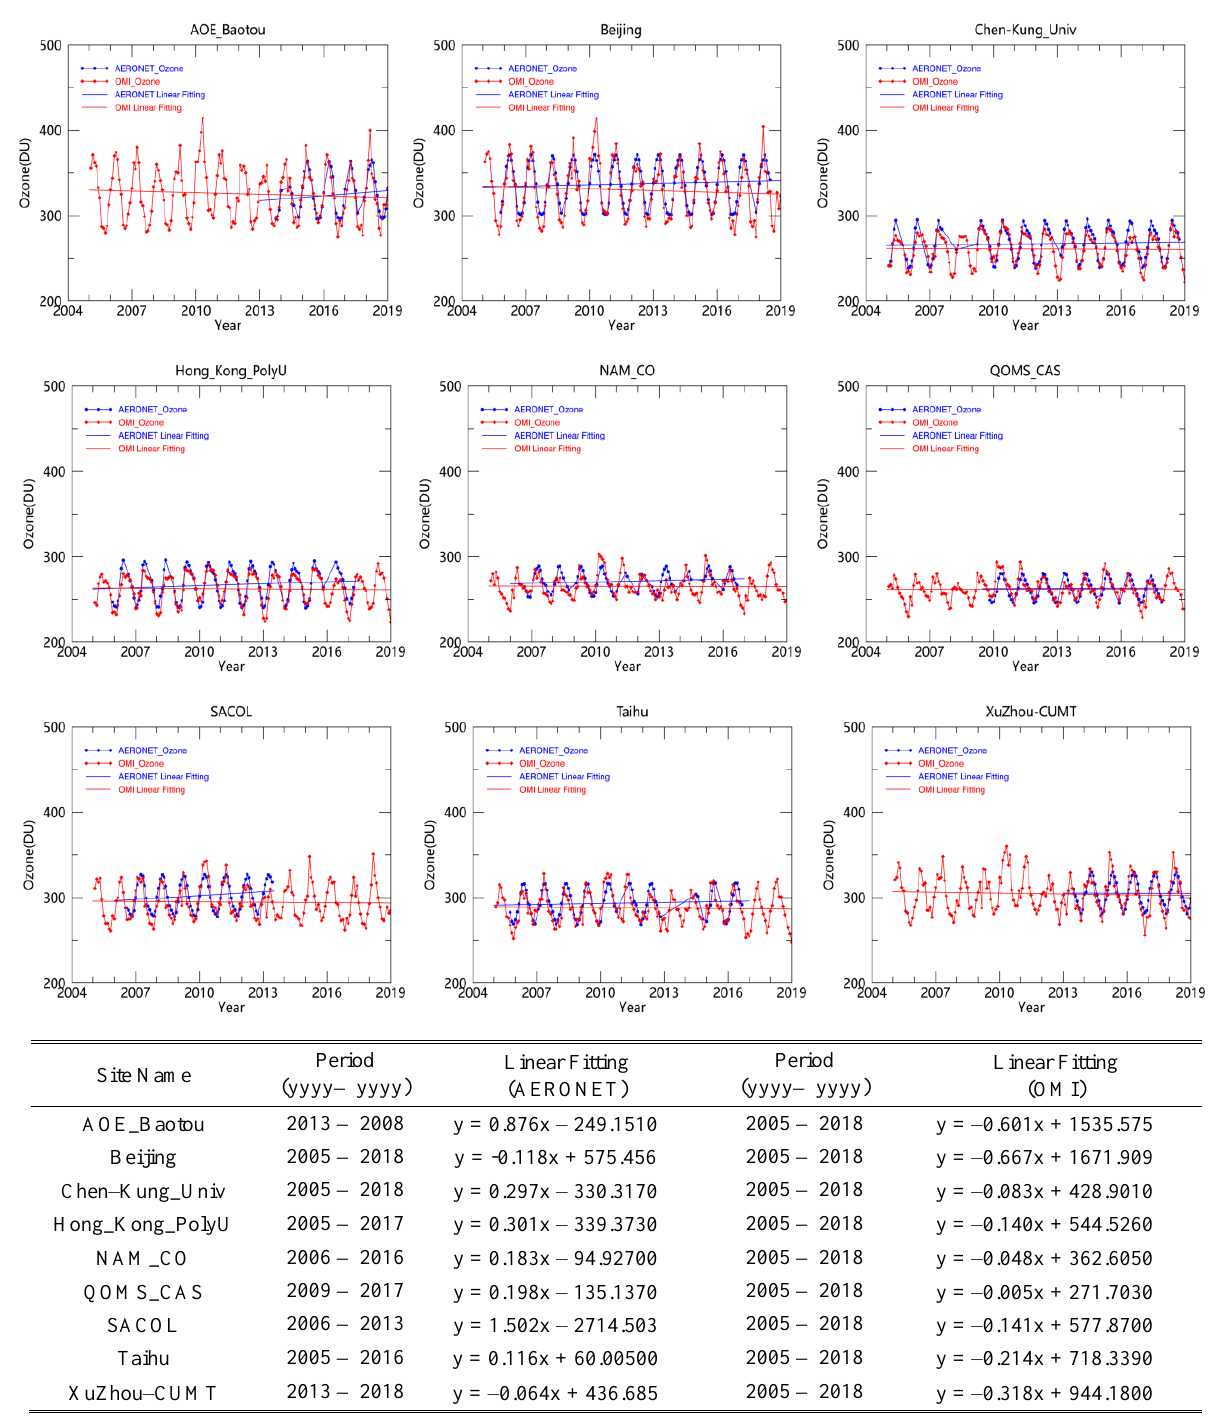
Figure 3. Monthly variation of the total ozone columns derived from satellite and ground observations at the study sites Table 2. Schematic table of linear fitting equation from 2005 to 2018 at the